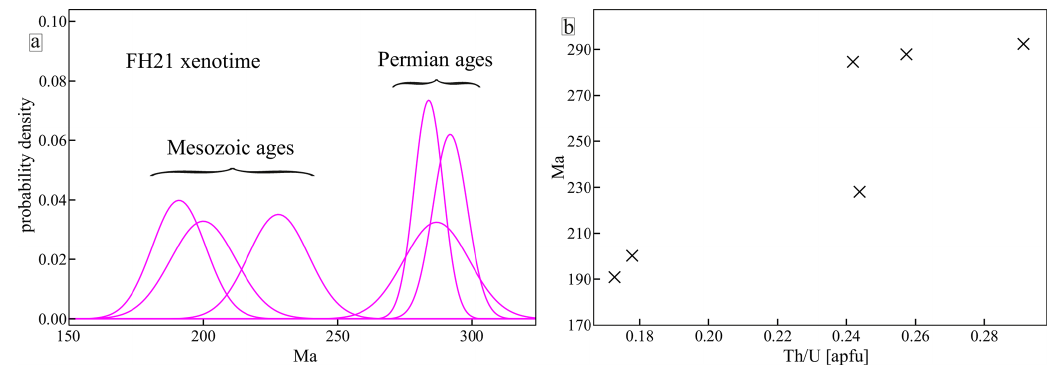
Figure 11. (a) Age distribution diagram for six measured xenotime points (pink curves) from sample FH21 (Fig. 10b, c). (b) Age vs. Th / U diagram of the same six measurement points.